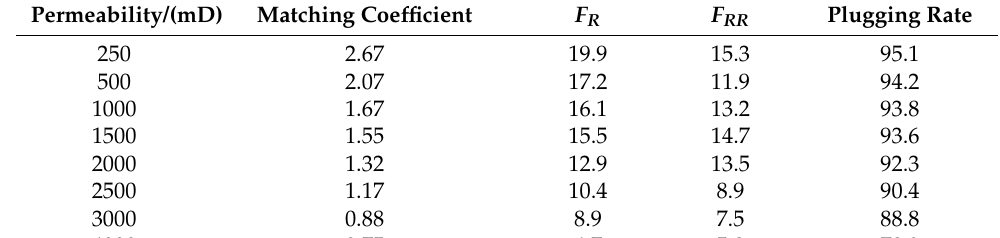
( b ) The produced fluid (reducing the permeability of core from left to right). Figure 6. The experiment results of matching between SMG- μ m and reservoir.